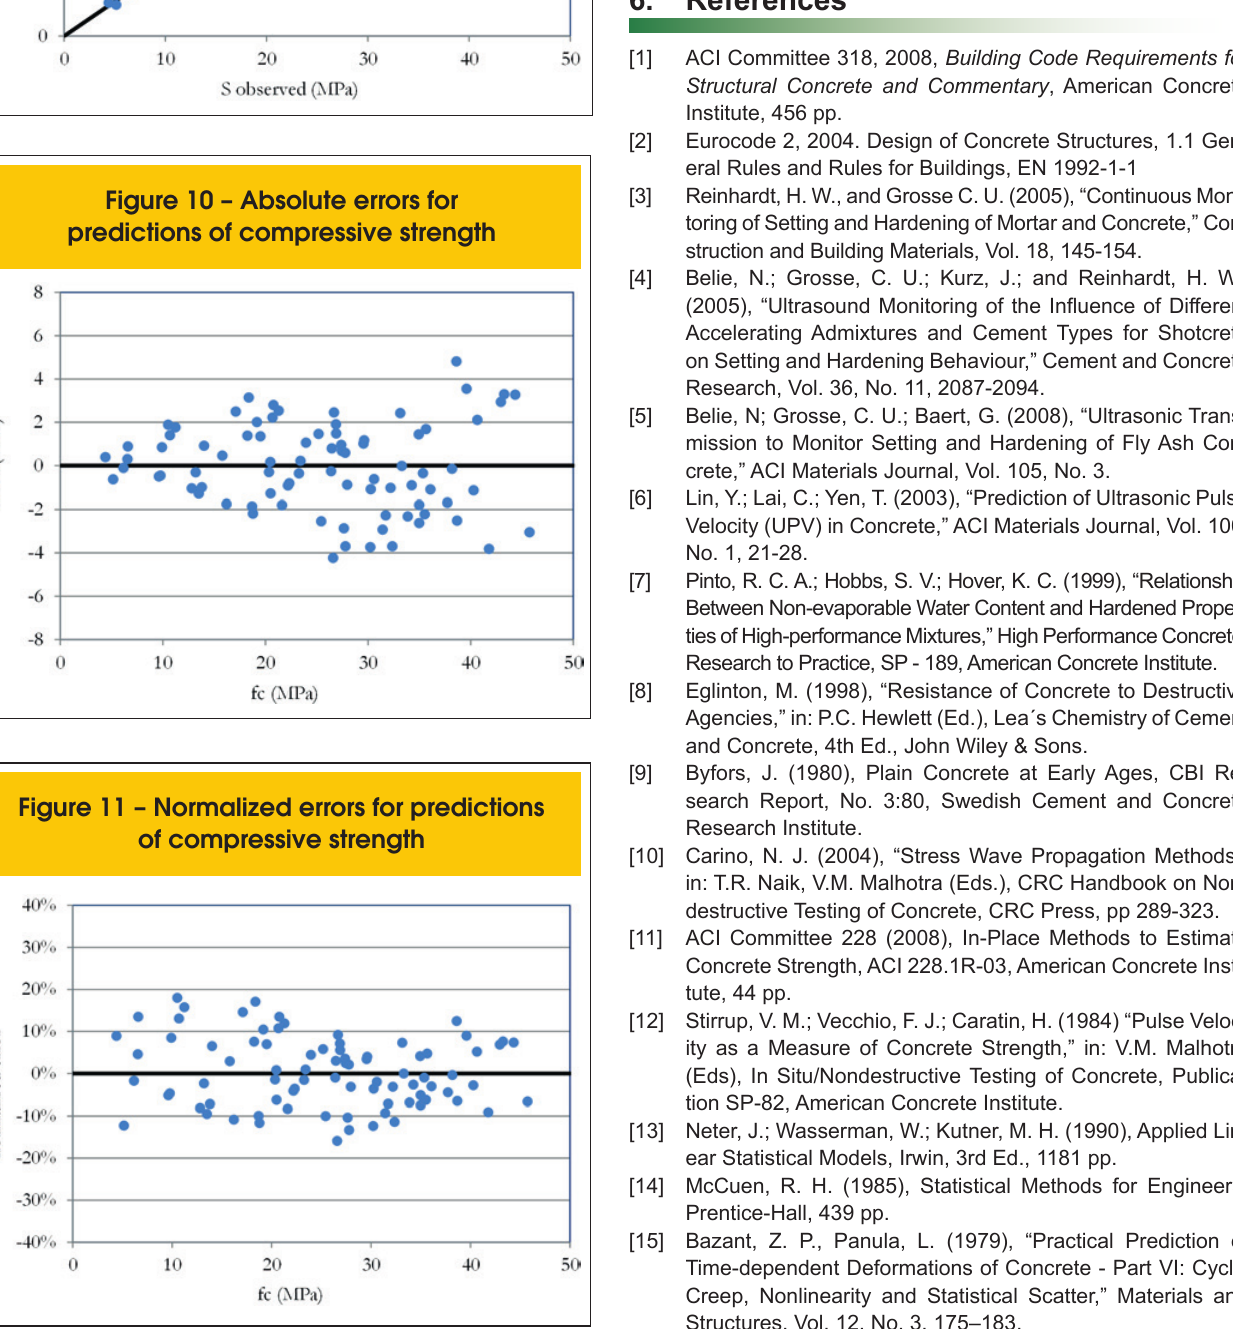
Figure 10 – Absolute errors for predictions of compressive strength